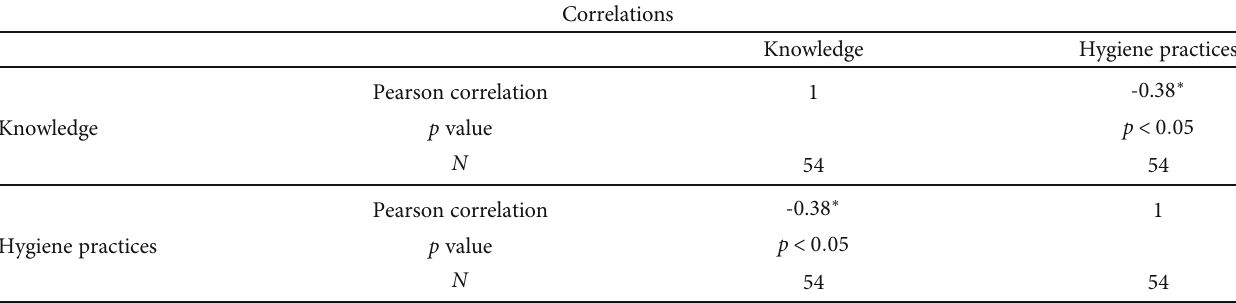
Table 7: The correlation between knowledge and hygiene practices at selected restaurants in Muscat